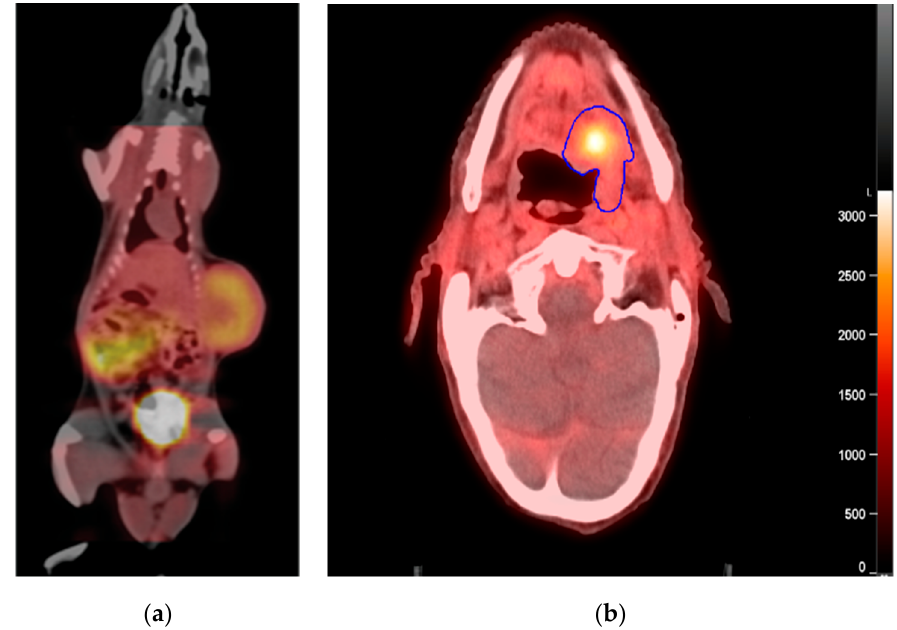
Figure 3. HX4 tracer accumulation in rats and patients. Units are provided in Becquerel/milliliter (Bq/mL) ( a ) Representative fused CT and PET image of a rhabdomyosarcoma R1 tumor ‐ bearing rats 4 h after injection of [18F] ‐ HX4. In this rat, tracer accumulation can be observed in the tumor and bladder, indicating selective tumor retention and renal excretion, respectively. Reproduced from Dubois et al., PNAS [6] ( b ) Representative fused CT and PET image of a head and neck cancer patient (NCT01504815 trial) 4 h after injection of [18F]-HX4 with defined primary gross tumor volume (blue)